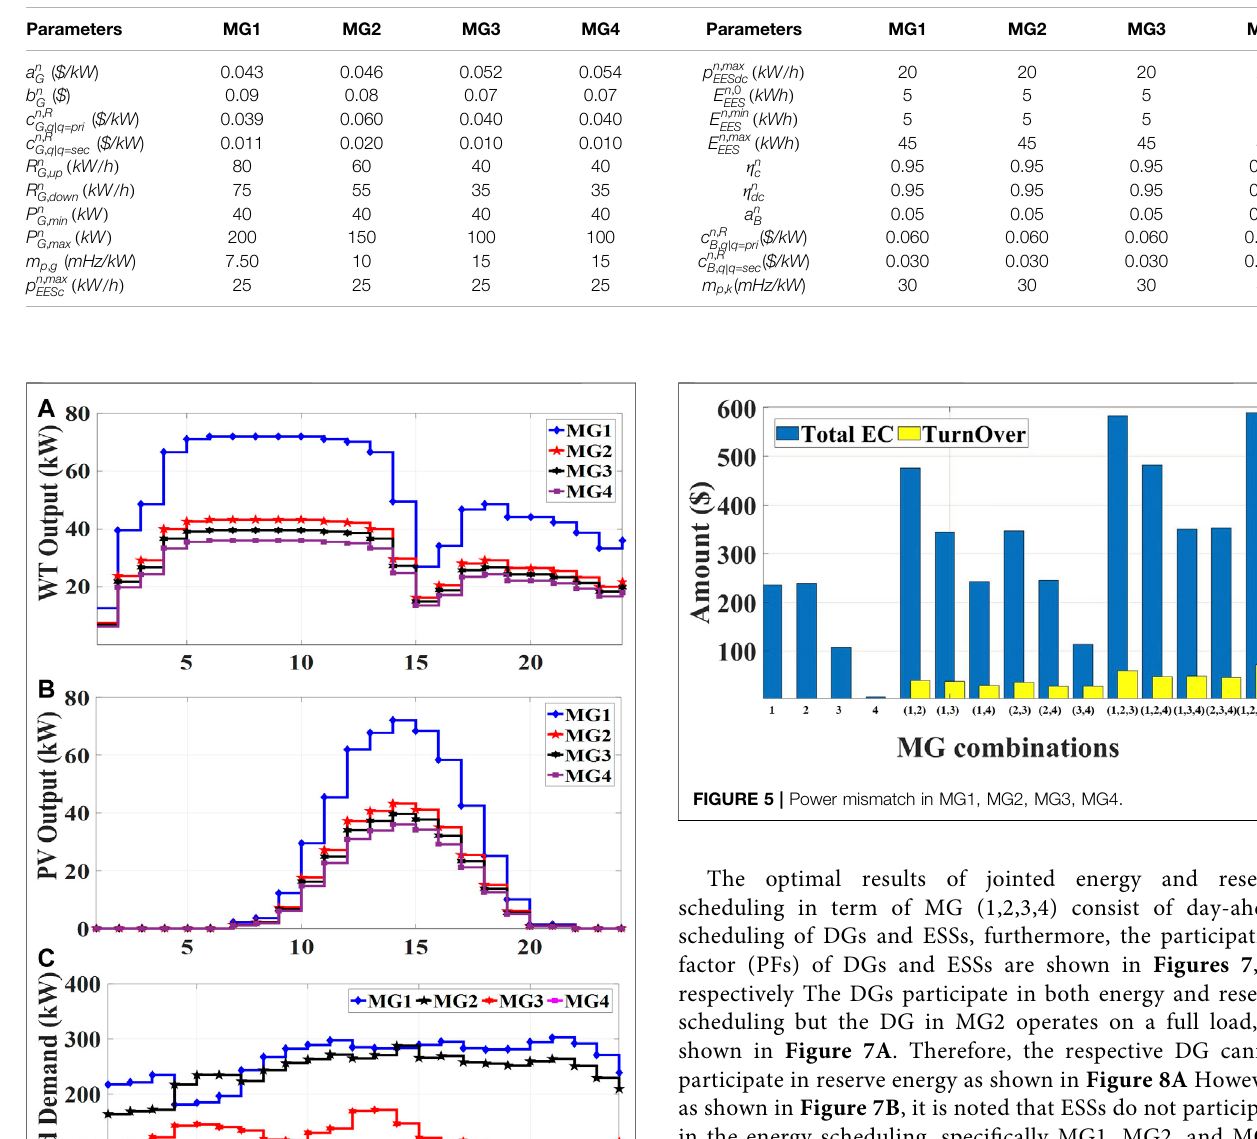
TABLE 1 | MGs-cluster